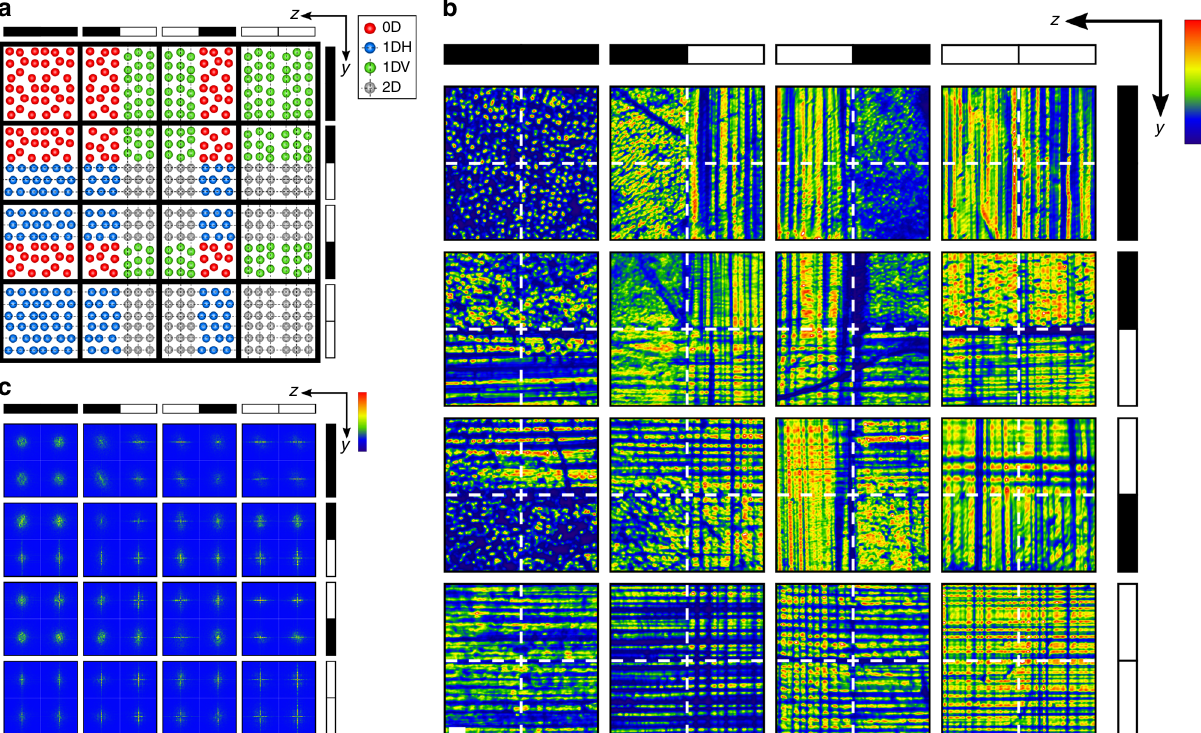
Fig. 4 Output generated by pairs of two-bit strings. a Expected and corresponding b experimental results of the 16 (2 2 × 2 2 ) patterns generated at the polymer cuboid output ( yz plane) by all combinations of a pair of 2-bit binary strings introduced along the y and z axis. Each output pattern comprises different combinations of carrier con fi gurations 0D (red), 1DH (blue), 1DV (green), and 2D (gray), which can be quanti fi ed through c corresponding FFT spectra of experimental results. (Bits 0 and 1 are represented by white and black bars, respectively; scale bar in b = 200 μ m; in b , c , blue (minimum) to red (maximum) intensity scales are